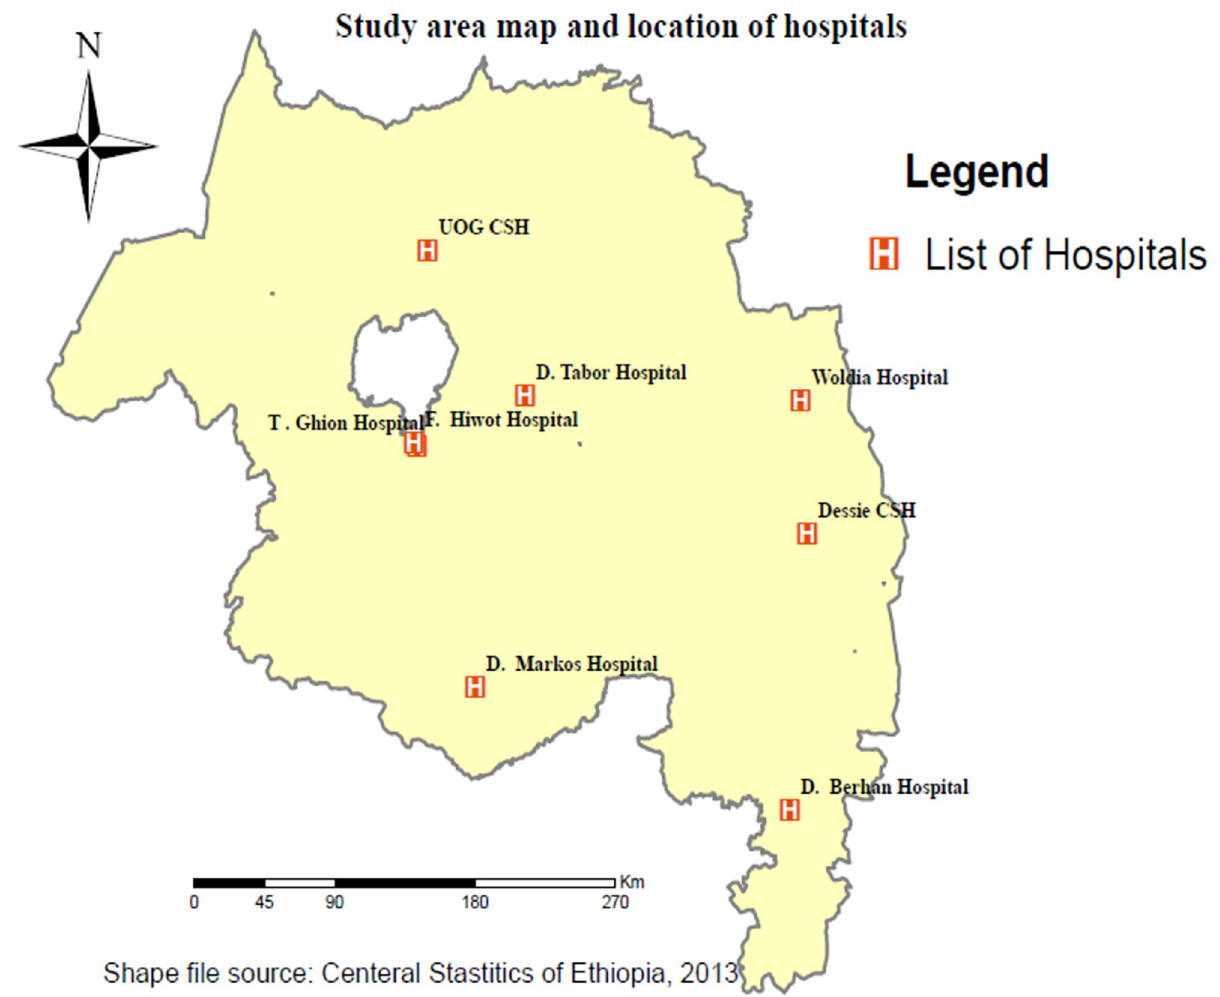
Fig 1. Schematic presentation of referral hospitals in Amhara regional state,